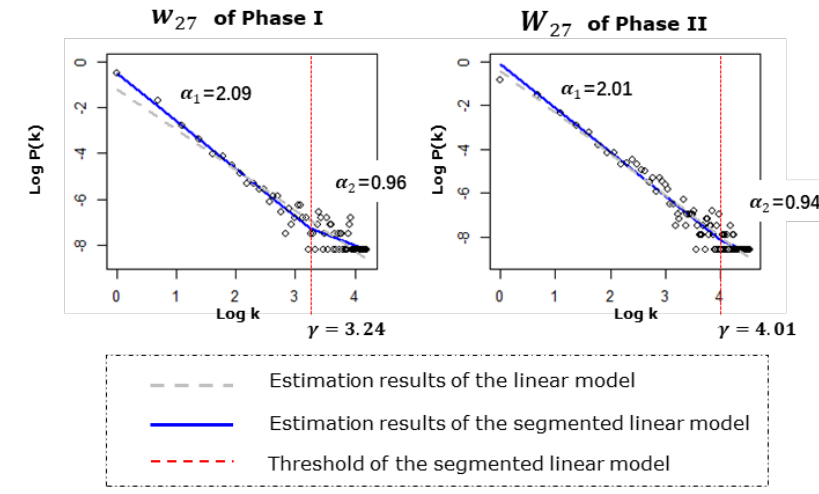
Figure 9. Estimation results of the linear and segmented linear models .